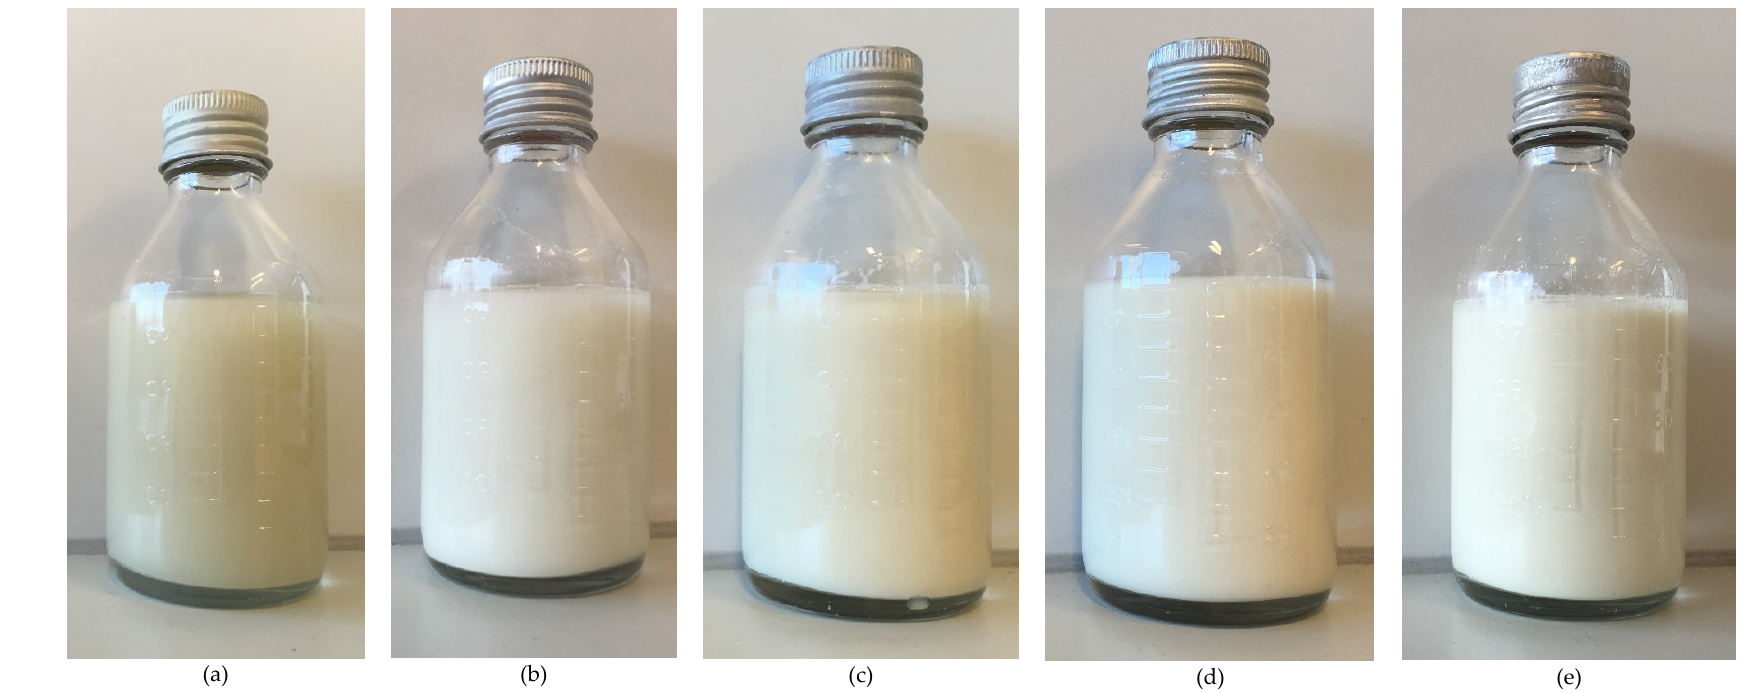
Figure 2. Bottles before 2 h of sedimentation. ( a ) Paper mill 1; ( b ) Landfill; ( c ) Cadaver; ( d ) Paper mill 2; ( e ) Paper mill 3.